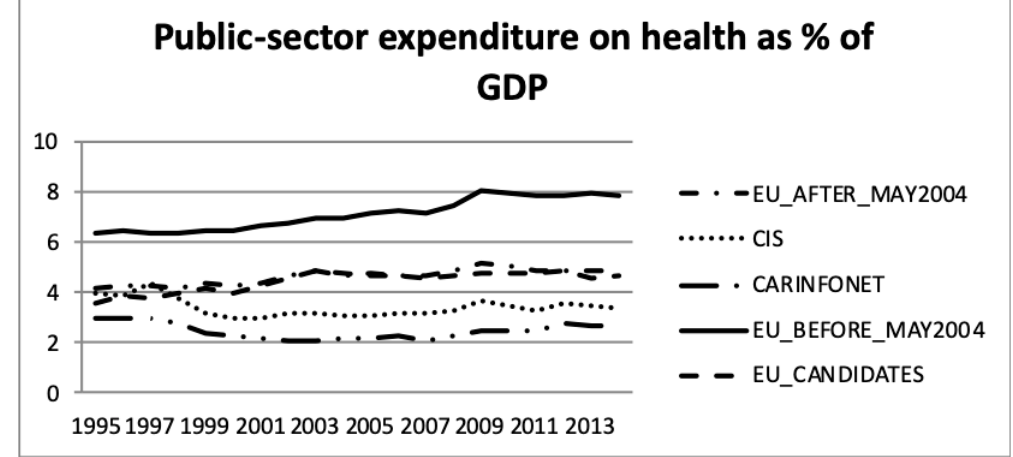
Figure 3. Public and private sector expenditure on health as a percentage of Gross Domestic Product (GDP), the World Health Organization estimates.